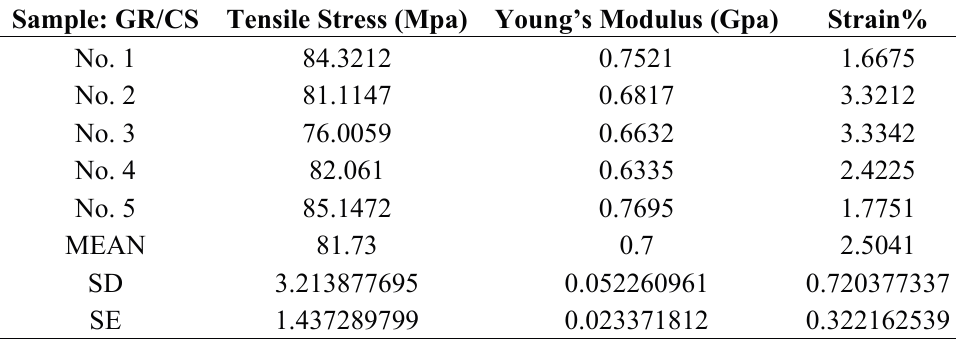
Table 2. Statistical analysis of the composite mechanical property. Sample: